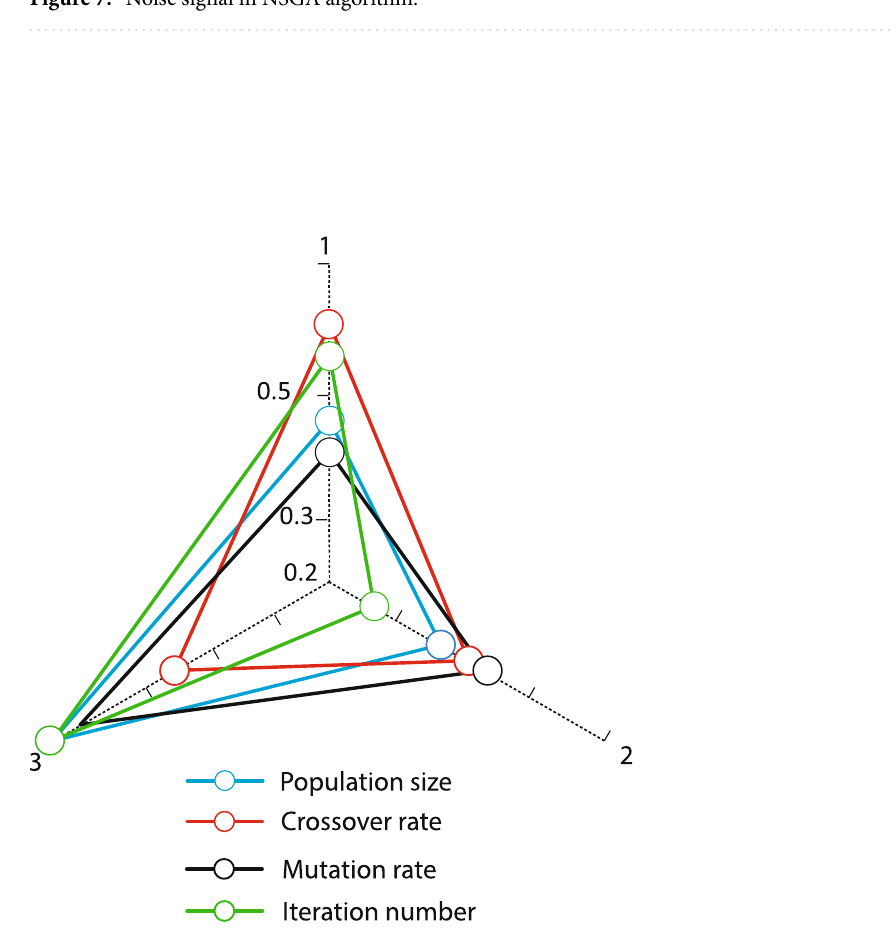
Figure 7. Noise signal in NSGA algorithm.